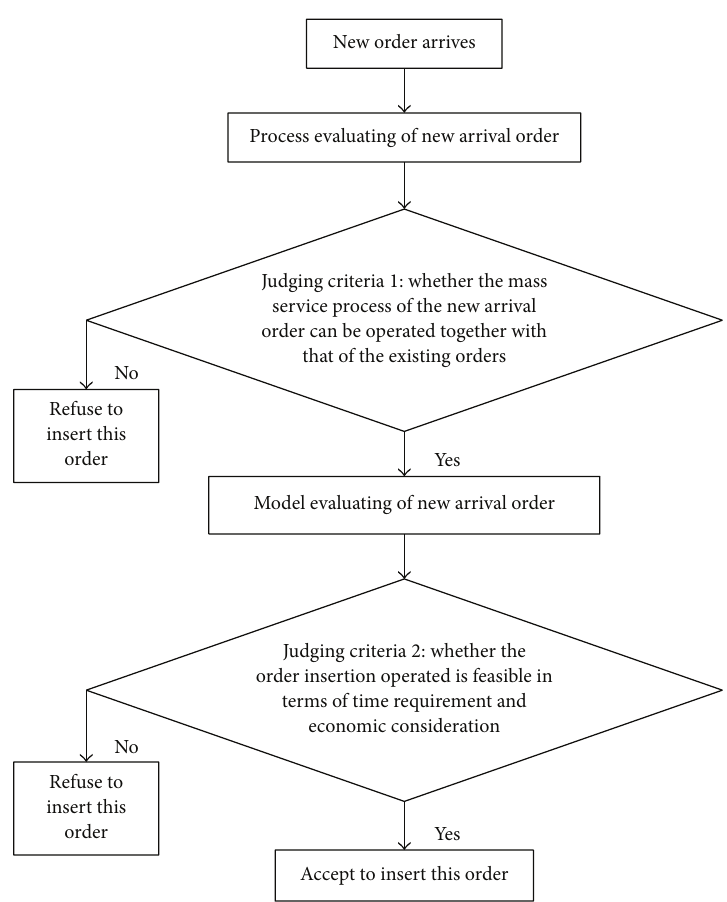
Figure 3: Determining process of new order’s insertion